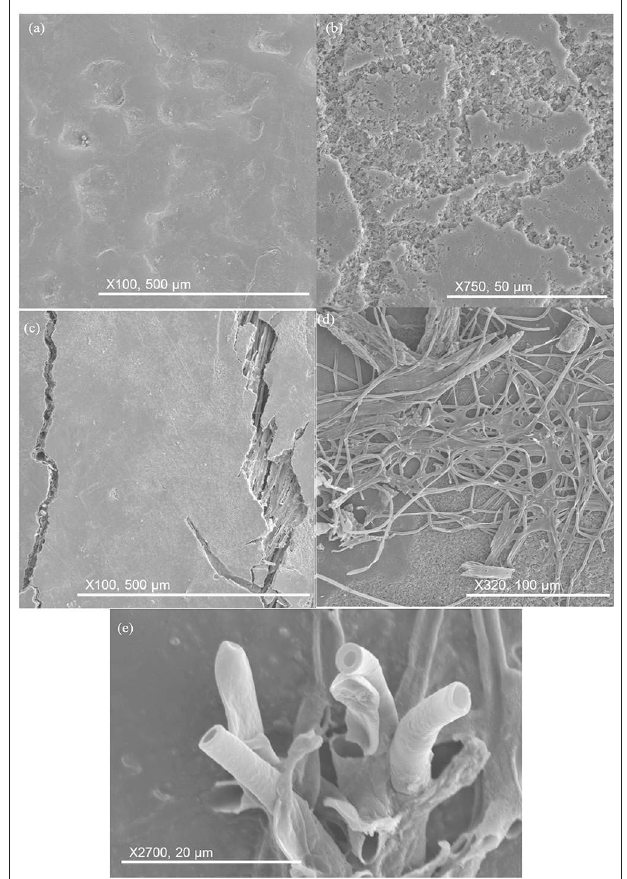
FIGURE 13 | SEM images of key changes after 84 days. (a) HIPS remains unchanged; (b) pits deepening in neat PHBV; (c ) surface cracking in composite samples, revealing fiber underneath; (d ) filament proliferation on PHBV/PBAT/flax and PHBV/ENR/flax; (e) filaments maturing and growing out of surface, having hollow and cylindrical appearance.